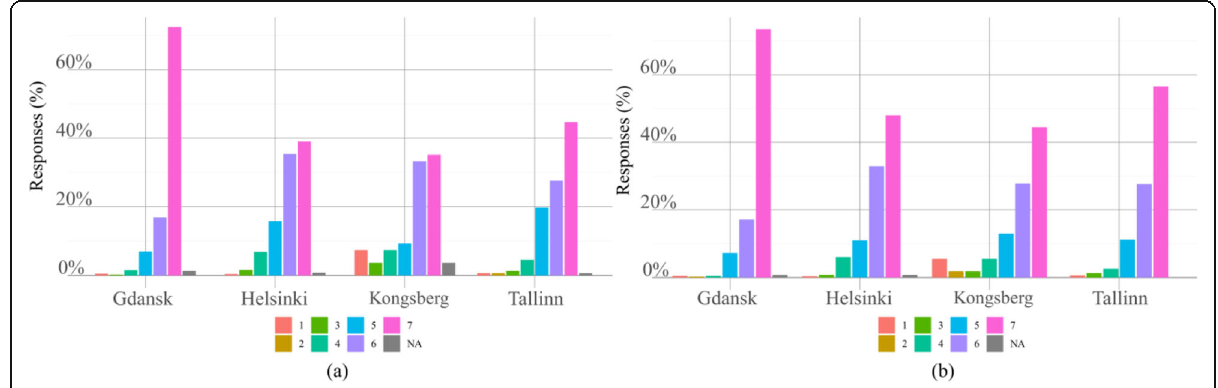
Fig. 3 Distribution of scores per city for passenger safety in ( a ), and personal security in ( b